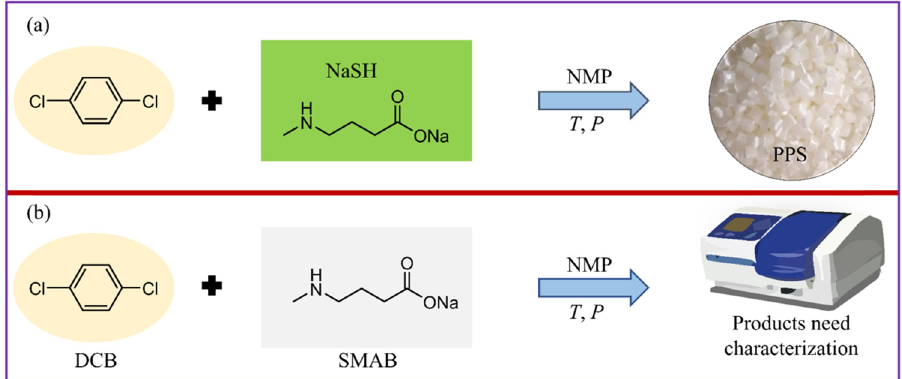
Figure 1: The reaction of DCB with ( b ) SMAB was carried out under conditions similar to the polymerization of ( a )